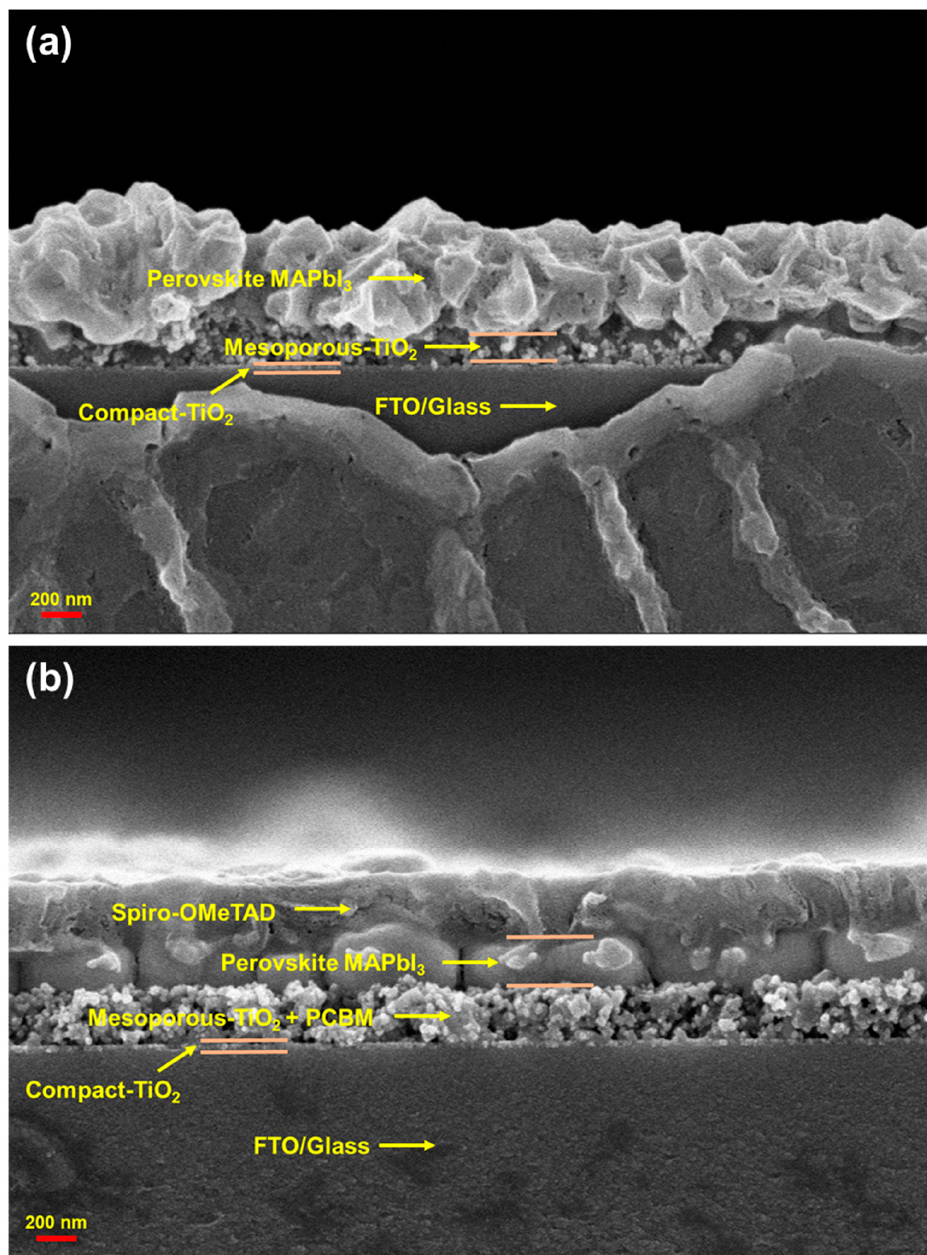
Figure 3. Cross-section FE-SEM images of ( a ) the MAPbI 3 /TiO 2 /FTO structure and ( b ) the spiro- OMeTAD/MAPbI 3 /PCBM/TiO 2 /FTO structure. The annealing temperature was 100 °C for 10 min.